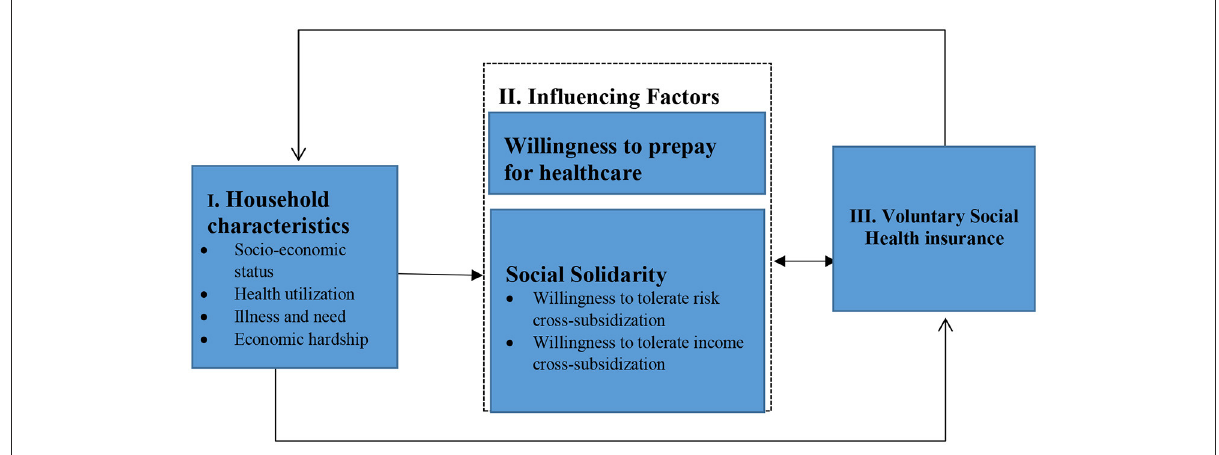
FIGURE1 Conceptual framework on willingness to prepay, social solidarity, and health insurance.